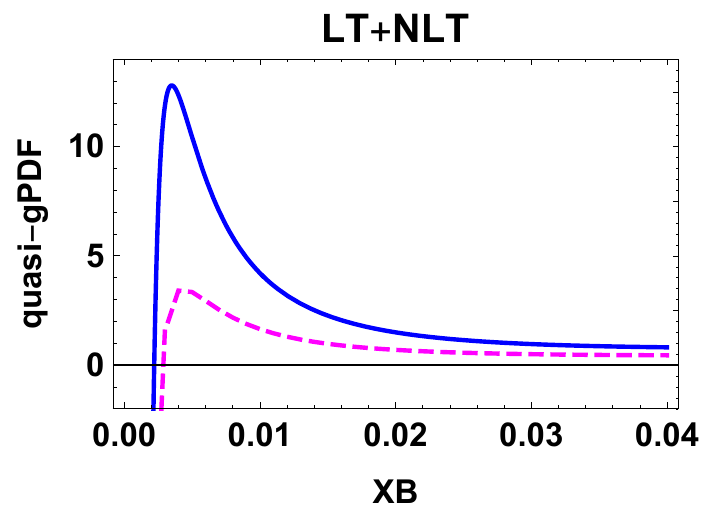
Figure 15 . We compare the real part of eq. (8.6) (magenta-dashed curve) with its approximation, real part of eq. (E.1) (blue curve). This is the case ln 4 P